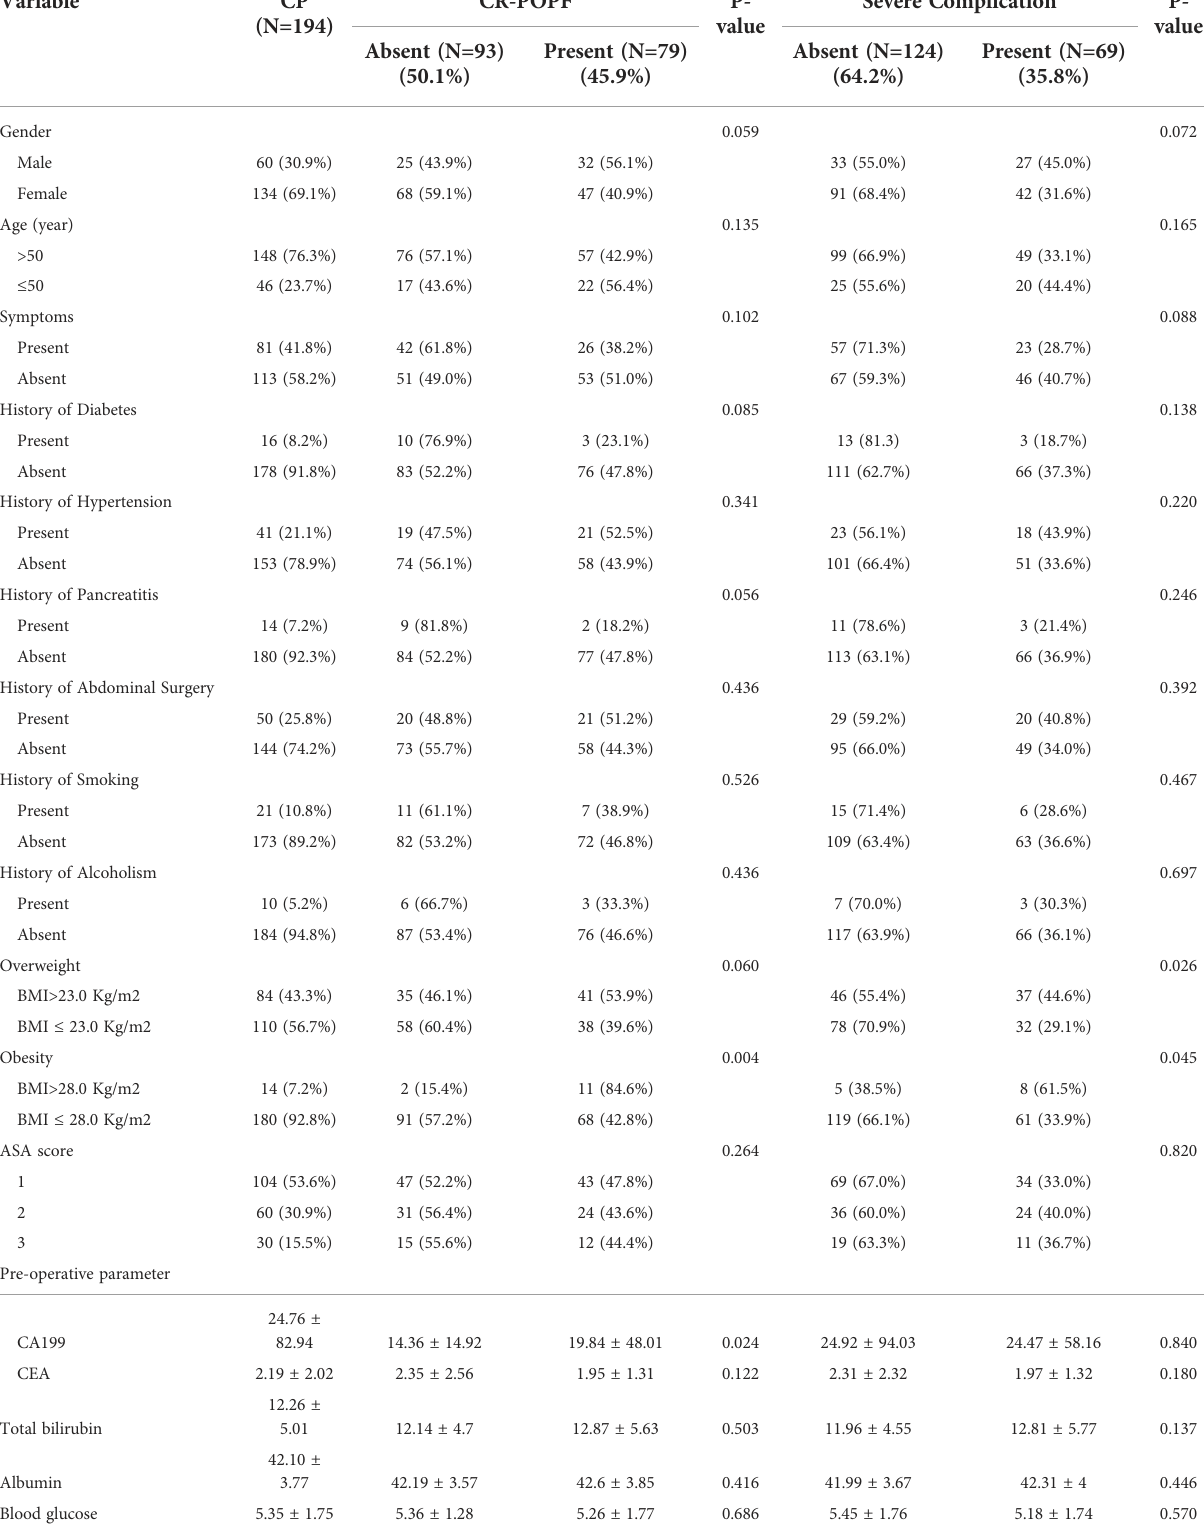
TABLE 1 Clinicopathological Characteristics and Postoperative